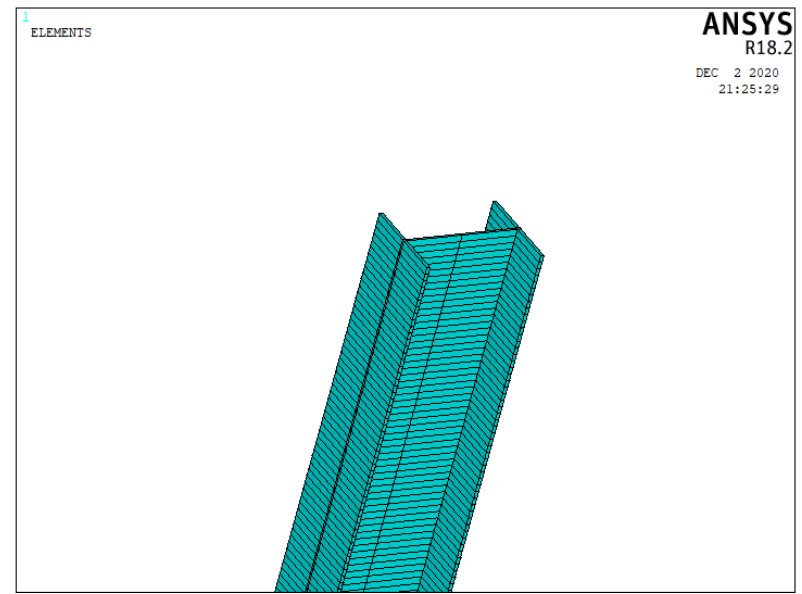
Figure 6. Grid division diagram of the H-section.